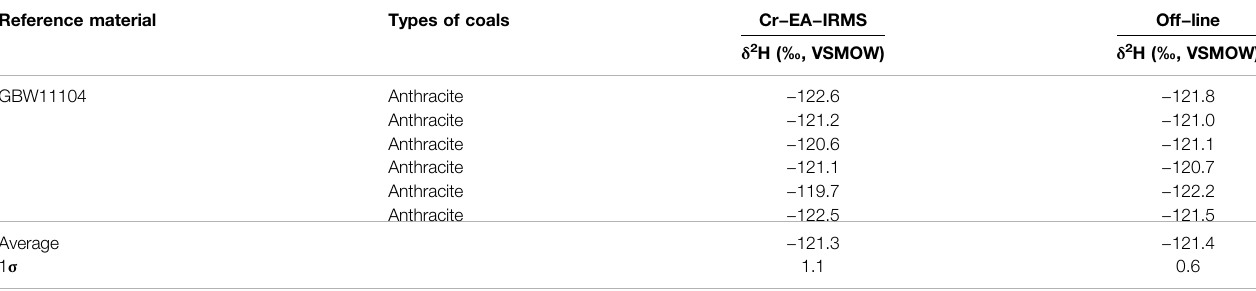
TABLE 1 | Analyses of δ 2 H of coal reference material